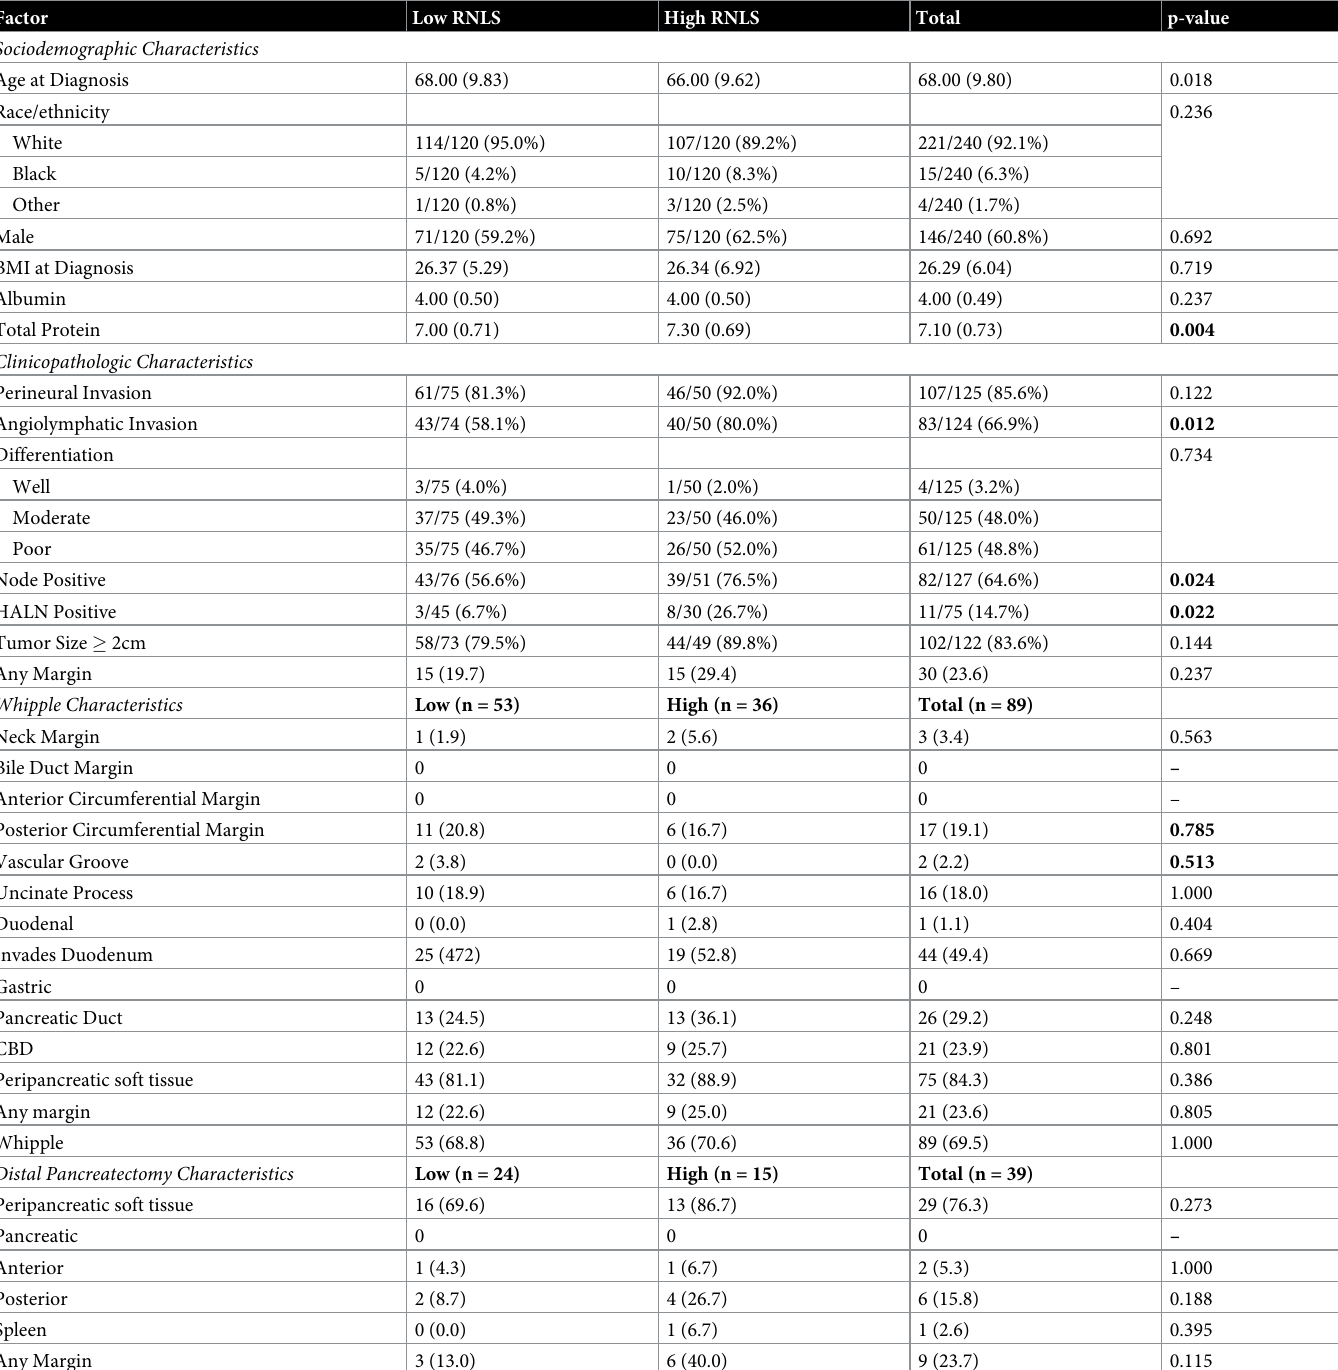
Table 3. Sociodemographic and clinicopathologic features among patients with PDAC with high vs. low plasma